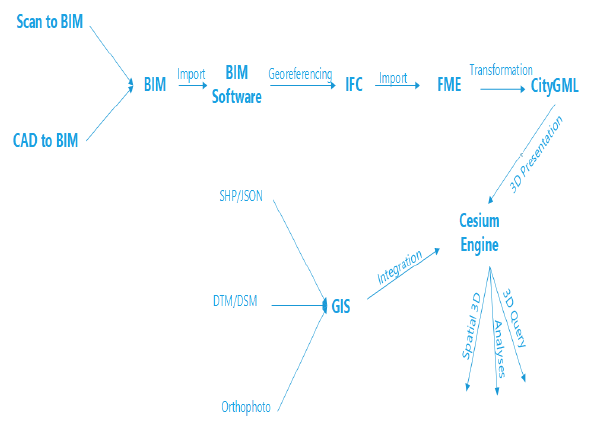
Figure 9. GIS/BIM Integration Model.